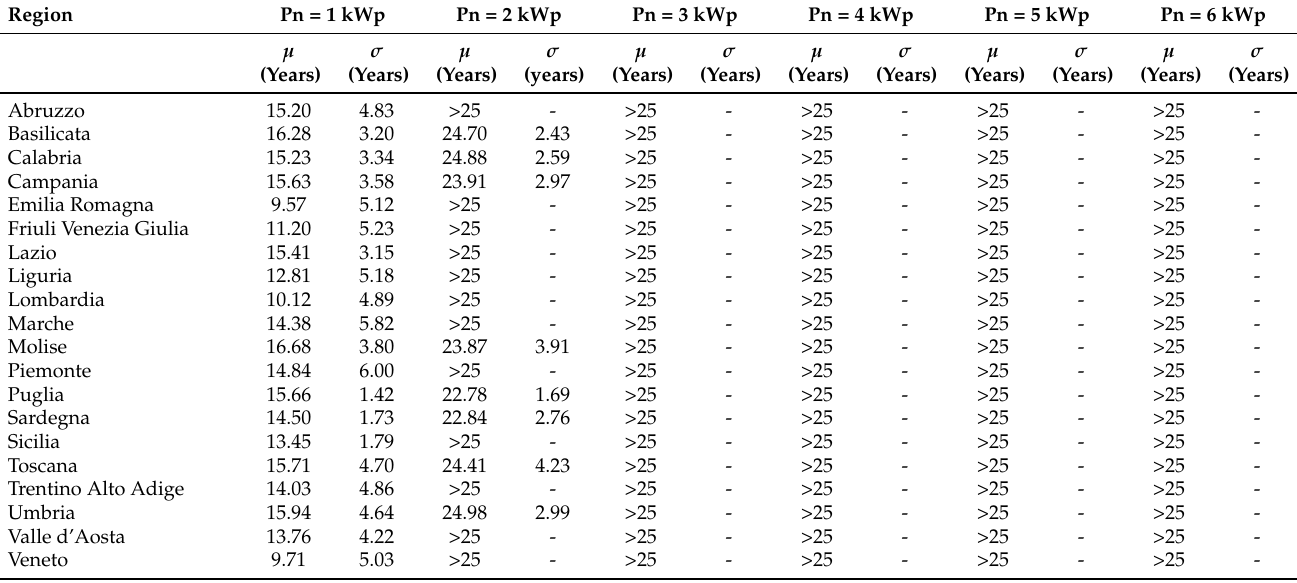
Table 16. DPBT for E L = 2700 kWh with